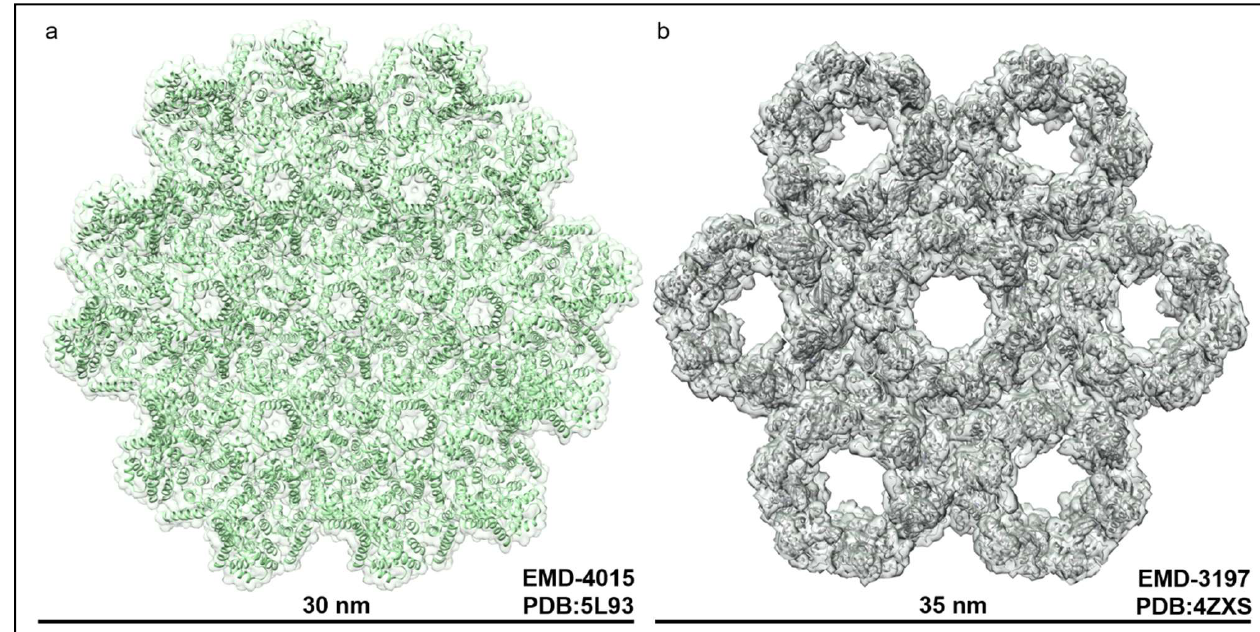
Figure 3. Both HSV-1 and HIV-1 form membrane bound hexagonal lattices that are involved in envelopment. HIV-1 Gag forms higher-order assemblies on the plasma membrane during viral budding. ( a ) The immature Gag lattice in green adopts a hexagonal geometry when bound to the plasma membrane and is found within immature virus particles. This viral complex must assemble on membranes in order to trigger the recruitment and activity of the membrane scission and sealing machinery. ( b ) The HSV-1 NEC complex binds to the inner nuclear membrane and assembles into a hexagonal lattice containing repeating units of a UL31-UL34 heterodimer. Structure of the HSV-1 NEC by fitting of the NEC crystal structure (PDB code: 4ZXS) into the 3D average of the NEC coat that was recently resolved via cryo-electron microscopy for Pseudorabies virus [36]. One repeating unit of the hexagonal lattice is shown, which has a diameter of approximately 35 nm. Note the differences in inter-subunit compaction and diameters between the assemblies.